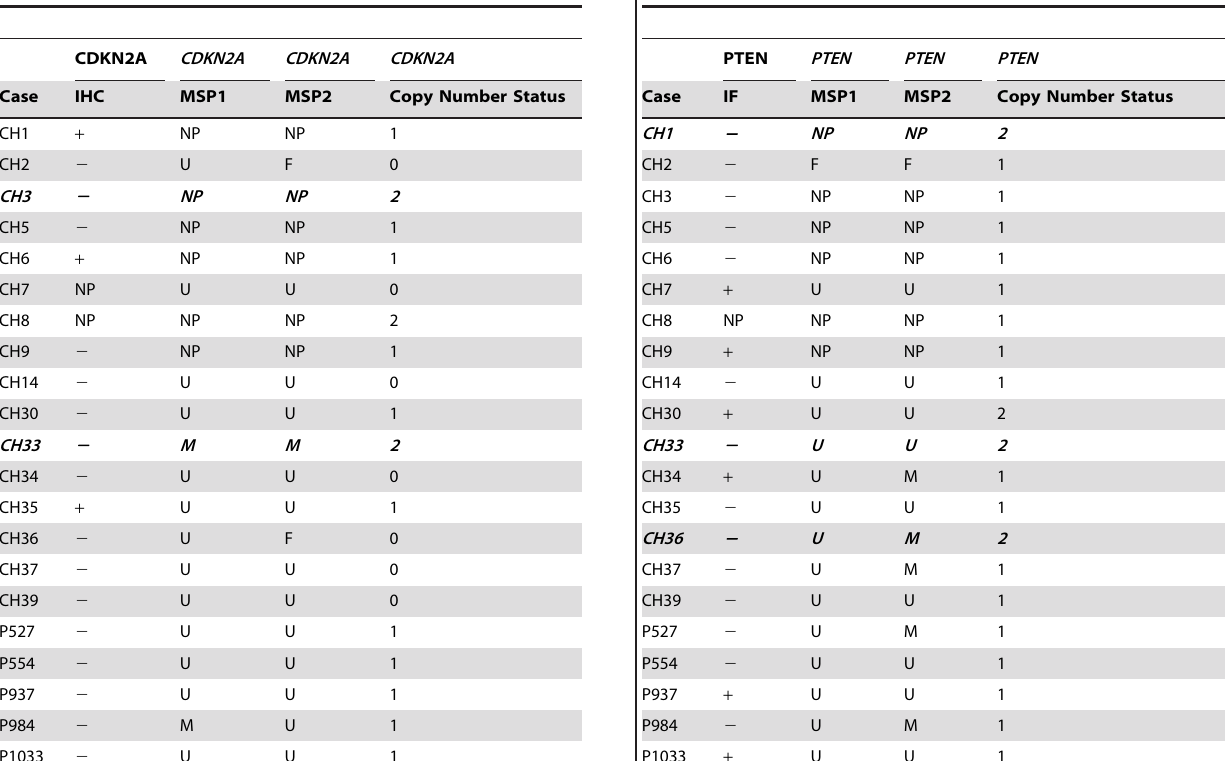
Table 3. CDKN2A analysis results. Table 4. PTEN analysis